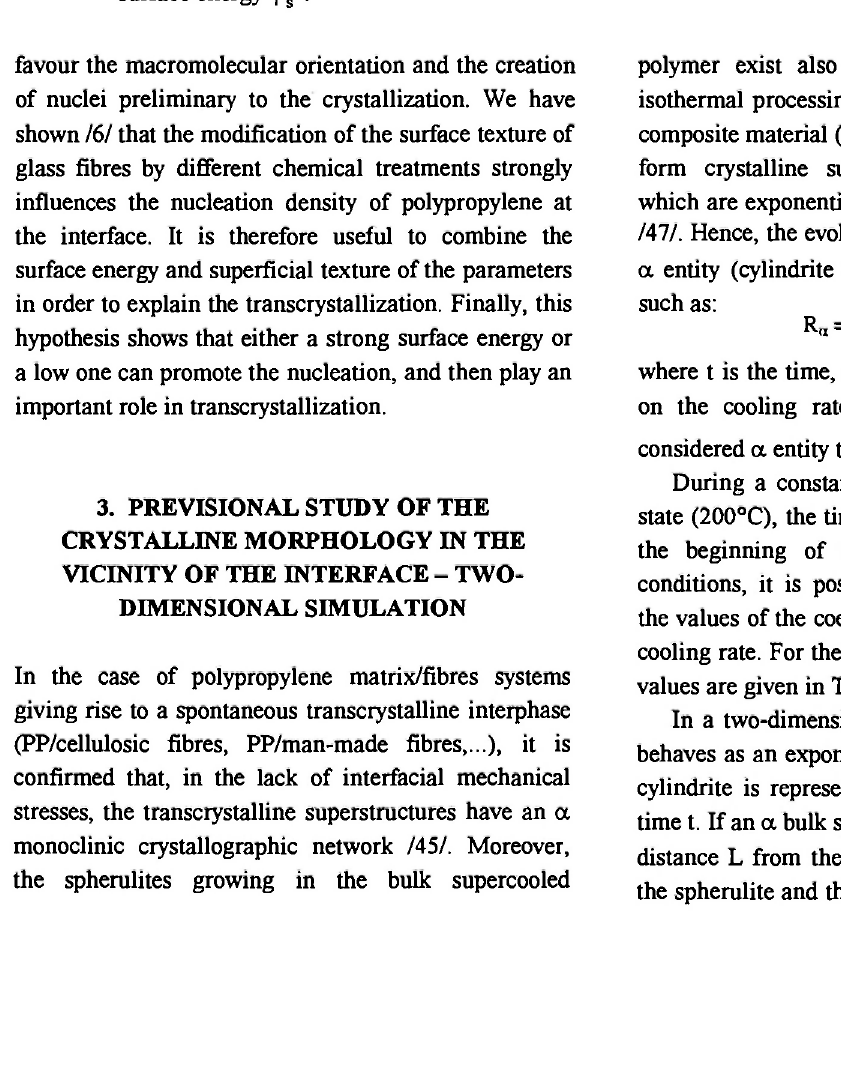
Evolution of the nucleation density on the glass slides as a function of the dispersive component of the surface energy γ